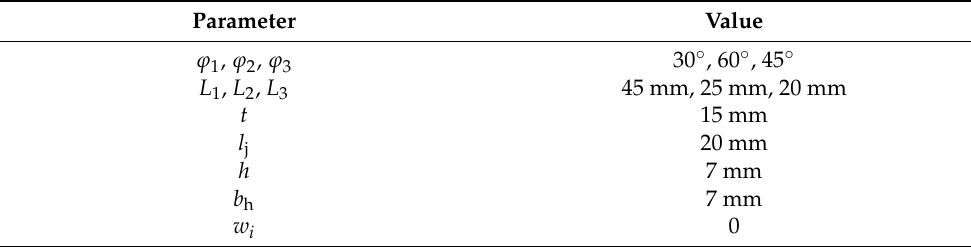
Table 1. Design Parameters of Hand